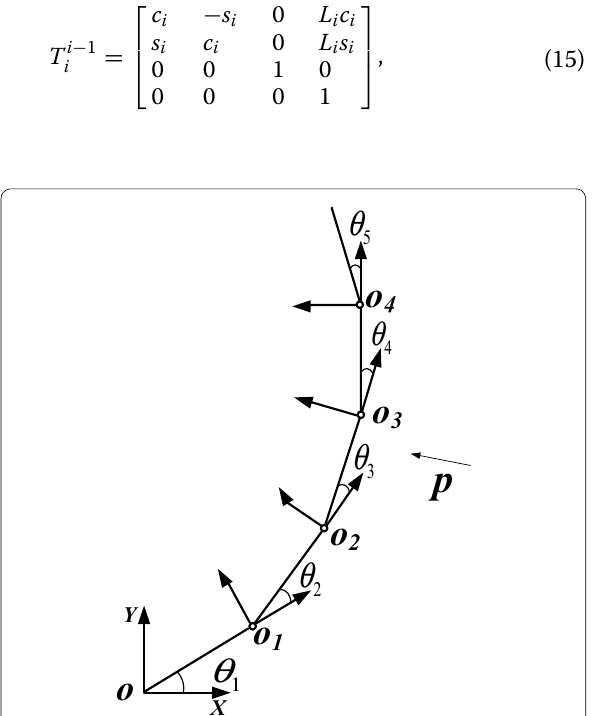
Figure 7 Cartesian coordinate system of a single finger